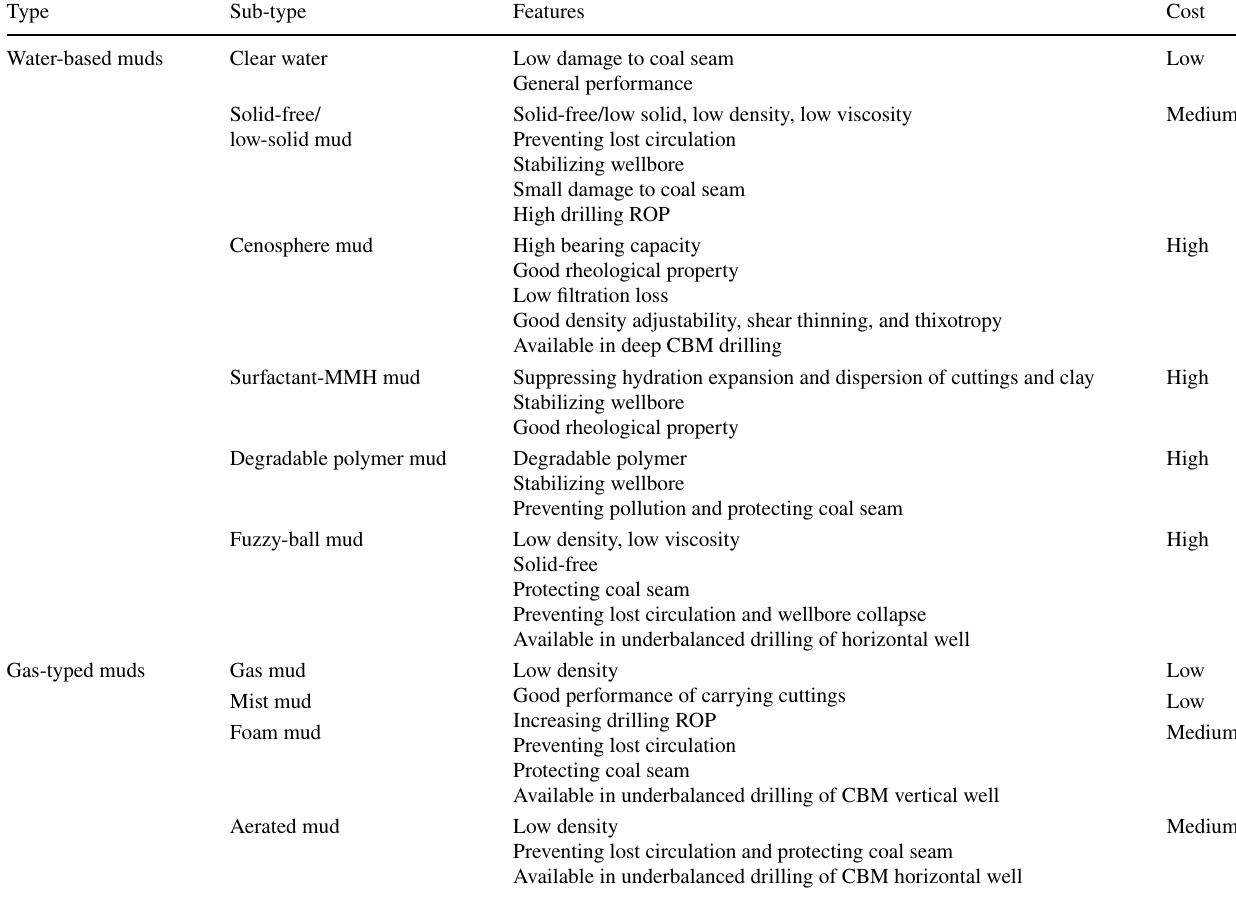
Table 6 CBM drilling fluids and its features